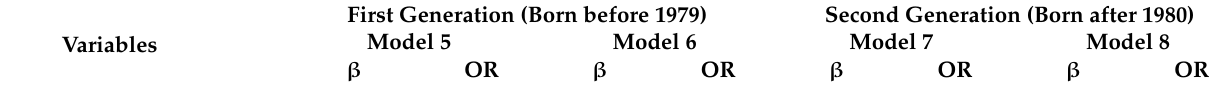
Table 4. Logit regression results for family migrants’ settlement intentions (by